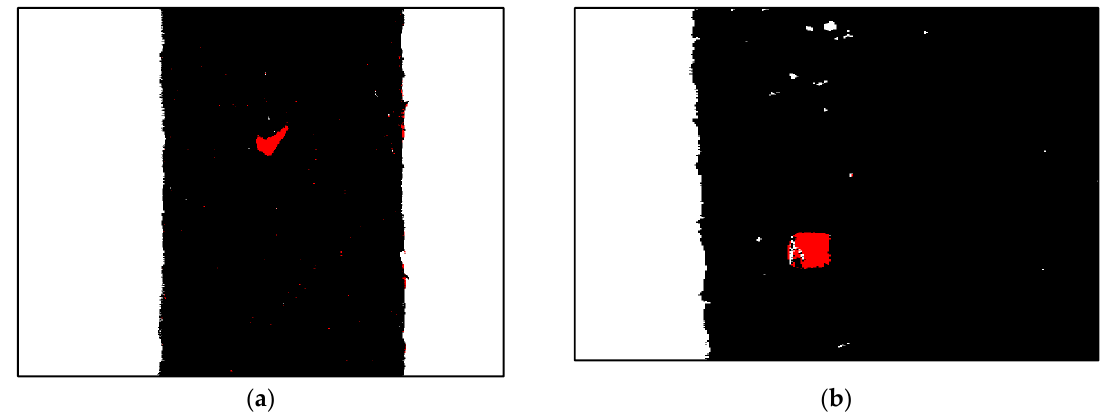
Figure 12. Classification result of the MCSVM. ( a ) Shrimp Shell ( b ) Black plastic bag